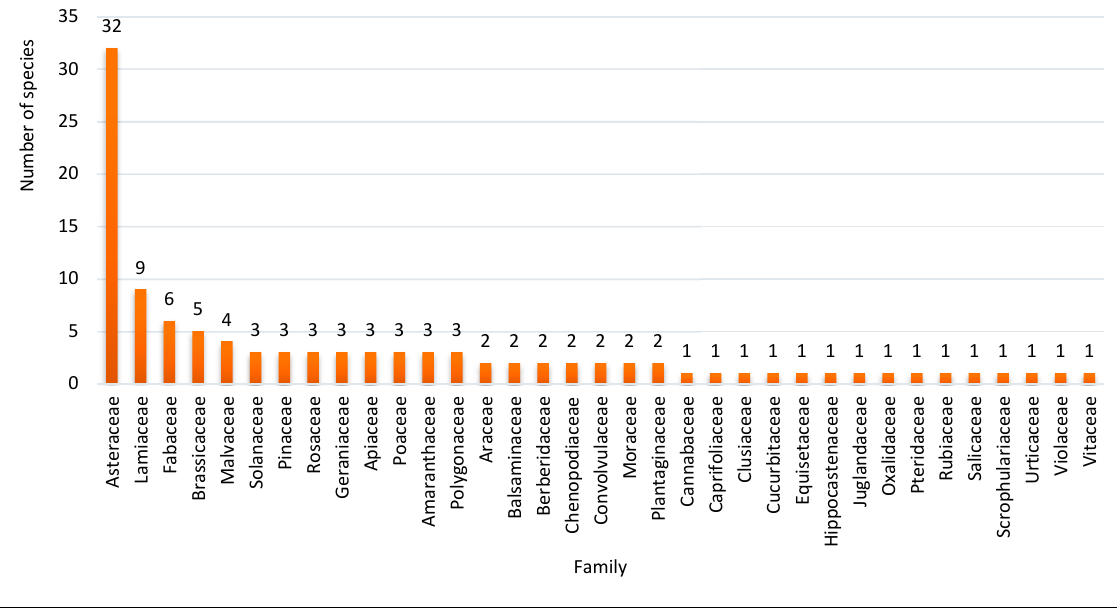
Figure 2. Species contribution of different families.